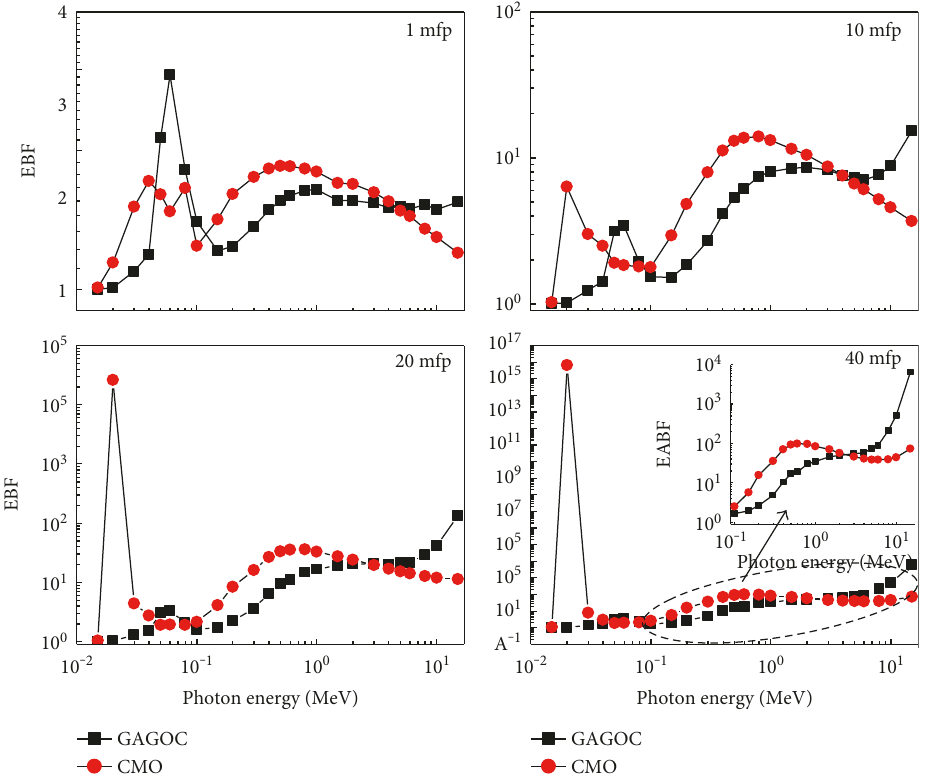
Figure 8: EBF variation for GAGOC and CMO with incident photon energy at 1, 10, 20, and